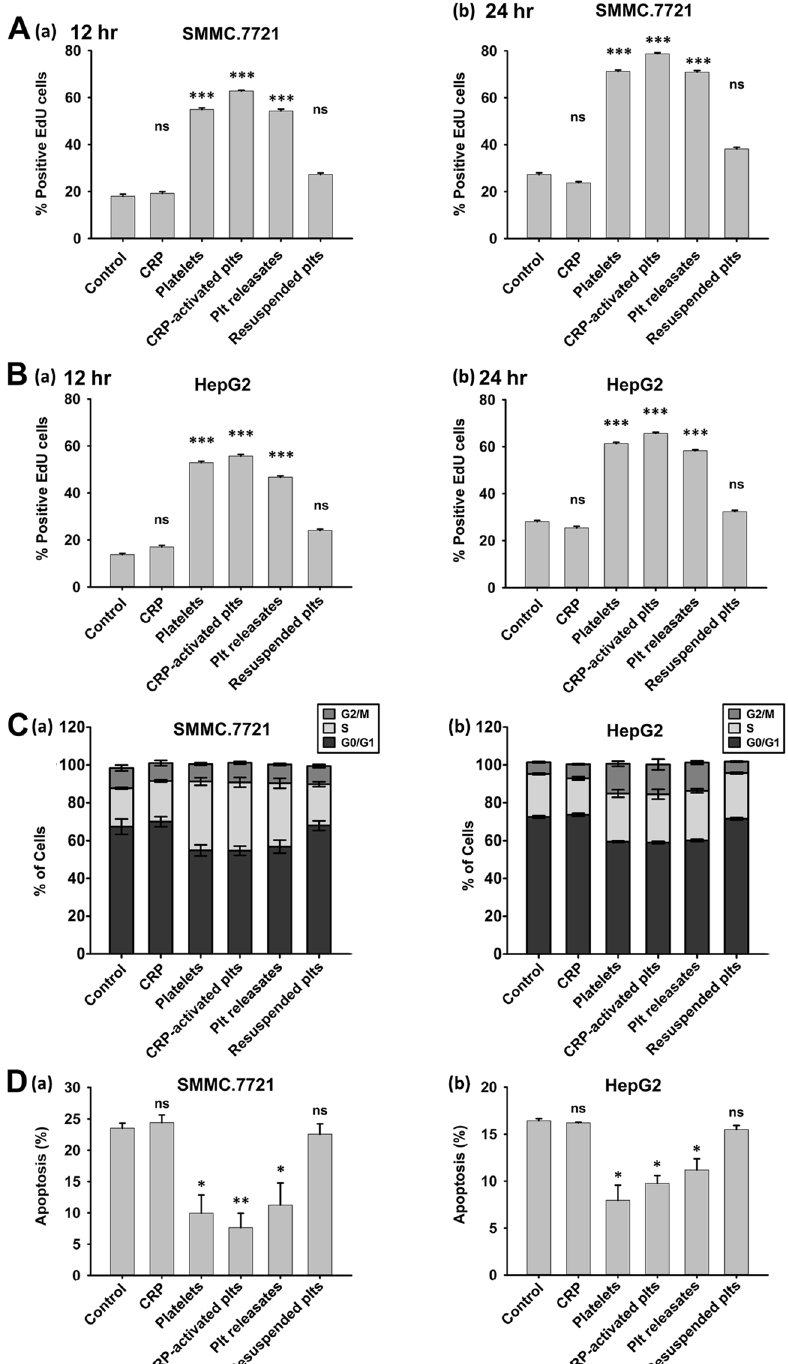
Figure 1. Platelets mediate the proliferation, cell cycle and apoptosis of HCC cells in vitro . ( A,B ) SMMC.7721 ( A ) and HepG2 ( B ) cells were incubated with resting platelets, platelets treated with specific stimulator CRP (0.8 μ g/ml), releasates of CRP-activated platelets, or the resuspended CRP-activated platelets pellet. The proliferation rate of HCC cells was assessed by measuring EdU incorporation after 12 (a) or 24 (b) hours of the above-indicated treatment, and cells cultured in fresh medium served as a control. EdU-positive cells were quantified in 5 randomly selected fields at x200 magnification, and the experiment was repeated 3 times. The results were expressed as the mean ± SEM ( *** p < 0.001 compared with the control). ( C ) Cell cycle analysis of SMMC.7721 (a) and HepG2 (b) cells after treatment with platelets, their releasates or resuspended platelets pellets for 24 hours (n = 3). ( D ) Apoptosis analysis of SMMC.7721 (a) and HepG2 (b) cells after treatment with platelets, their releasates or resuspended platelets pellets for 24 hours (n = 3), and cells cultured in fresh medium served as a control. * p < 0.05 and ** p < 0.01 were determined by Student’s t-test, plts: